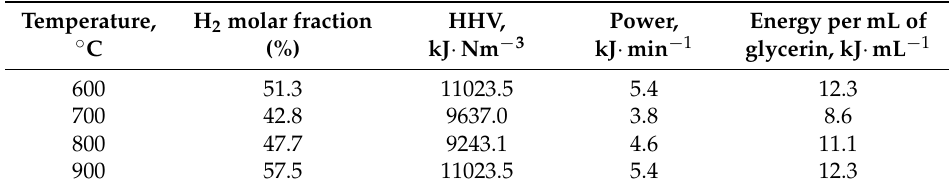
Table 3. Characteristic parameters from glycerin steam gasification. Effect of temperature. Water/glycerin ratio (9/1). Flow rate 3 mL ∙ min − 1 .